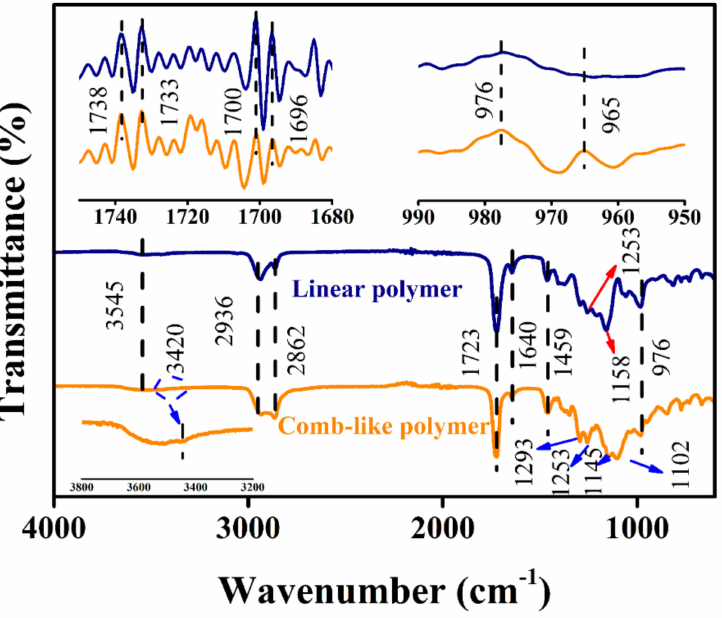
Figure 2. The FTIR spectrum and the second derivative spectrum of linear polyester and comb-like